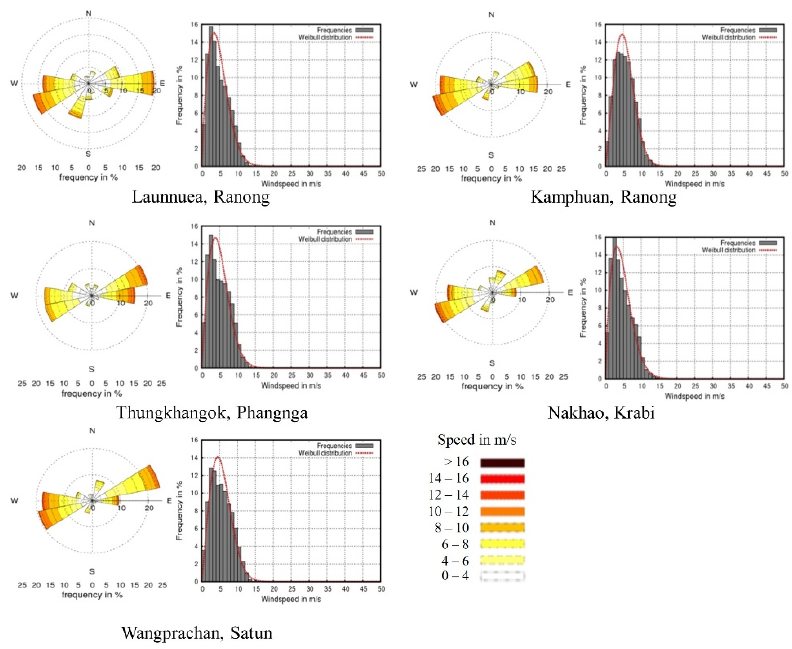
Figure 10. Wind rose diagrams and Weibull probability density functions at 120 m agl for the potential sites for wind power development.